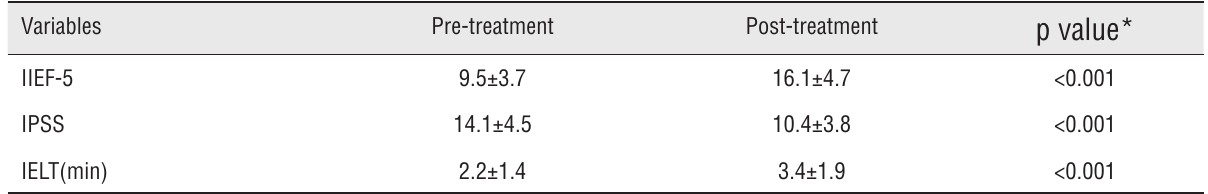
Table 2 - Baseline and post tadalafil 5 mg daily treatment IELT, IPSS and IIEF-5 scores of patients. Variables Pre-treatment Post-treatment